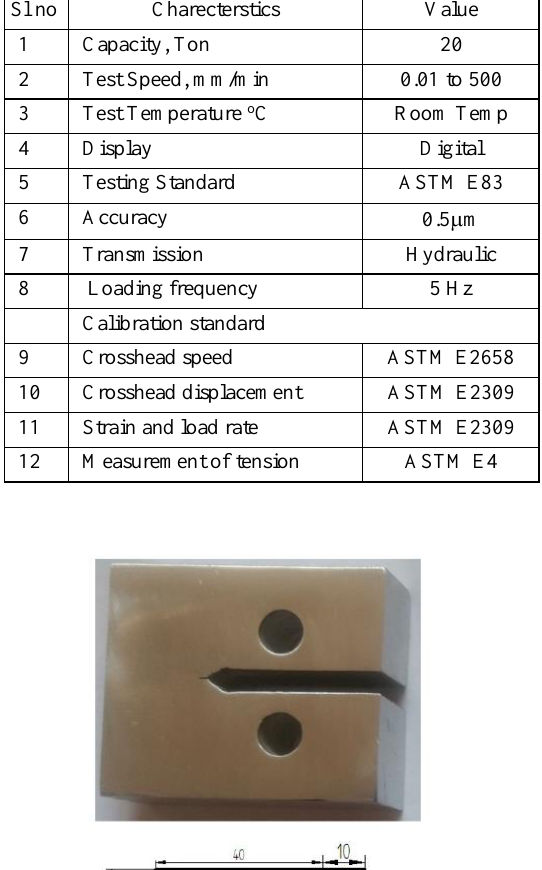
Figure 1. CT Specimen with